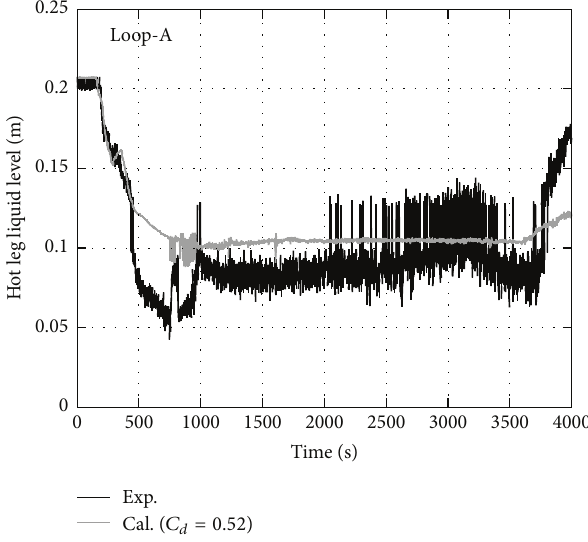
Figure 13: LSTF and RELAP5 results for hot leg liquid level in loop- A in case of release of dissolved